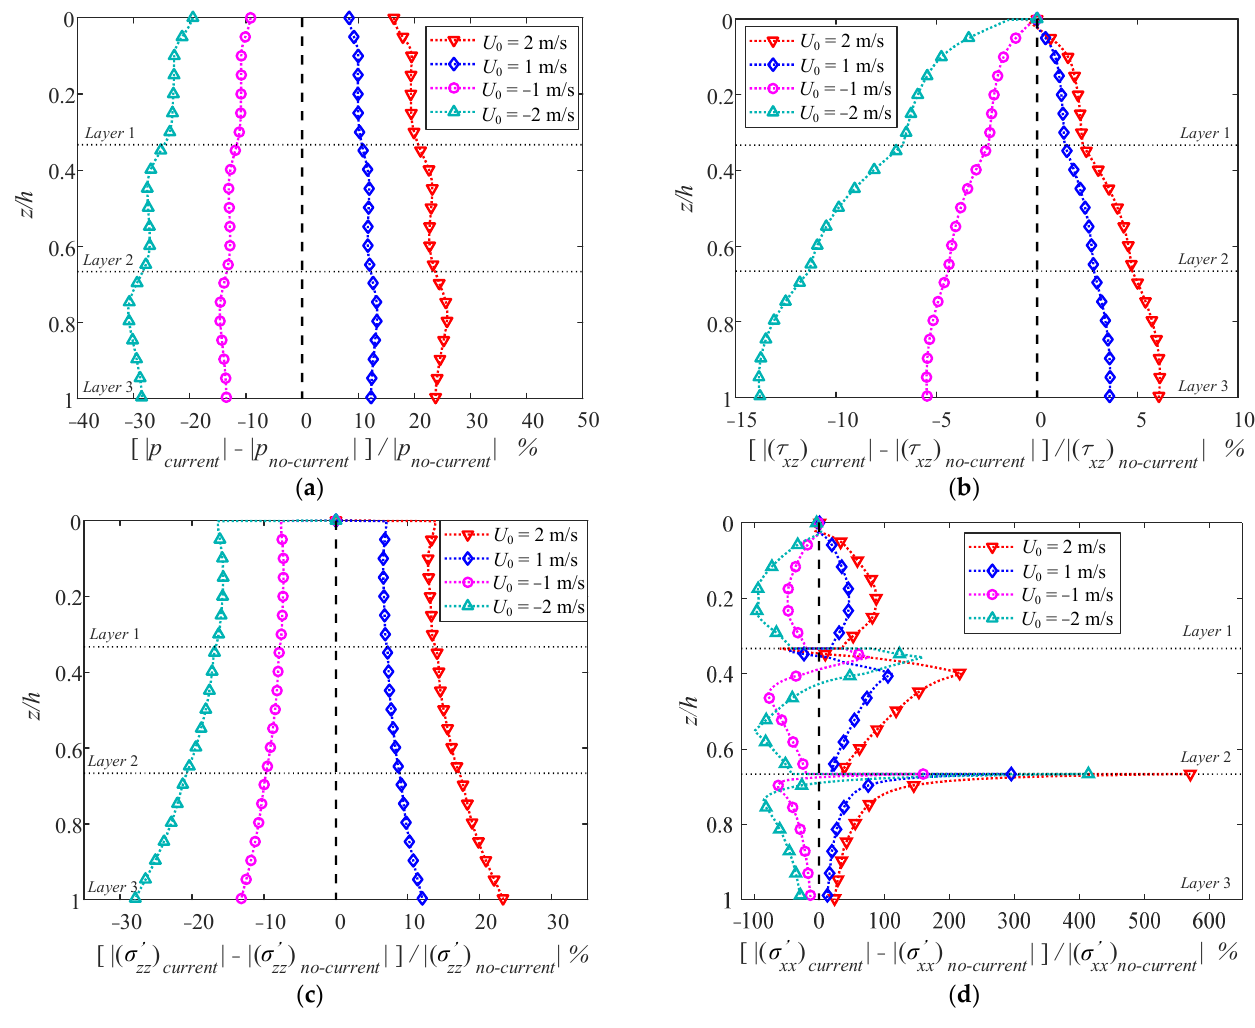
Figure 21. Vertical distributions of the normalized relative difference in soil ( a ) pore pressure, ( b ) shear stress, ( c ) vertical effective stress, and ( d ) horizontal effective stress between the presence and absence of a current .